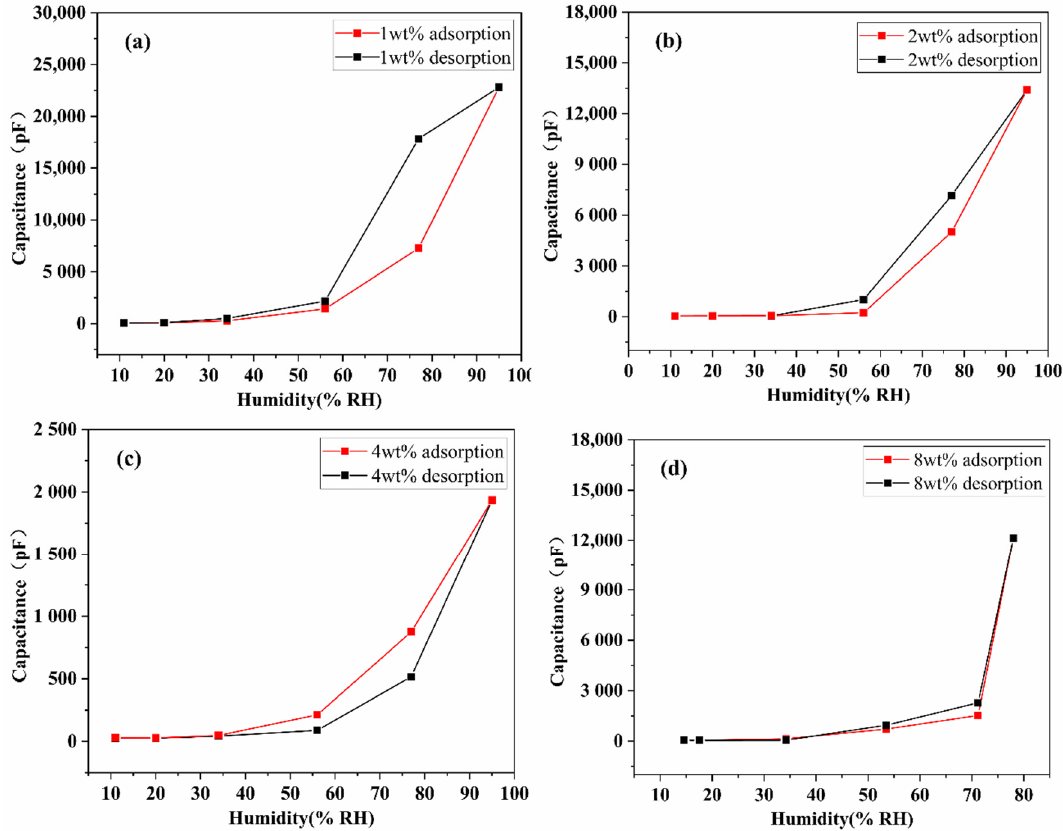
Figure 7. Hysteresis characteristics of SnO 2 /rGO sensor in the water molecules adsorption and desorption (11%RH–95%RH–11%RH). ( a ) 1 wt% SnO 2 /rGO, ( b ) 2 wt% SnO 2 /rGO, ( c ) 4 wt% SnO 2 /rGO, and ( d ) 8 wt% SnO 2 /rGO.